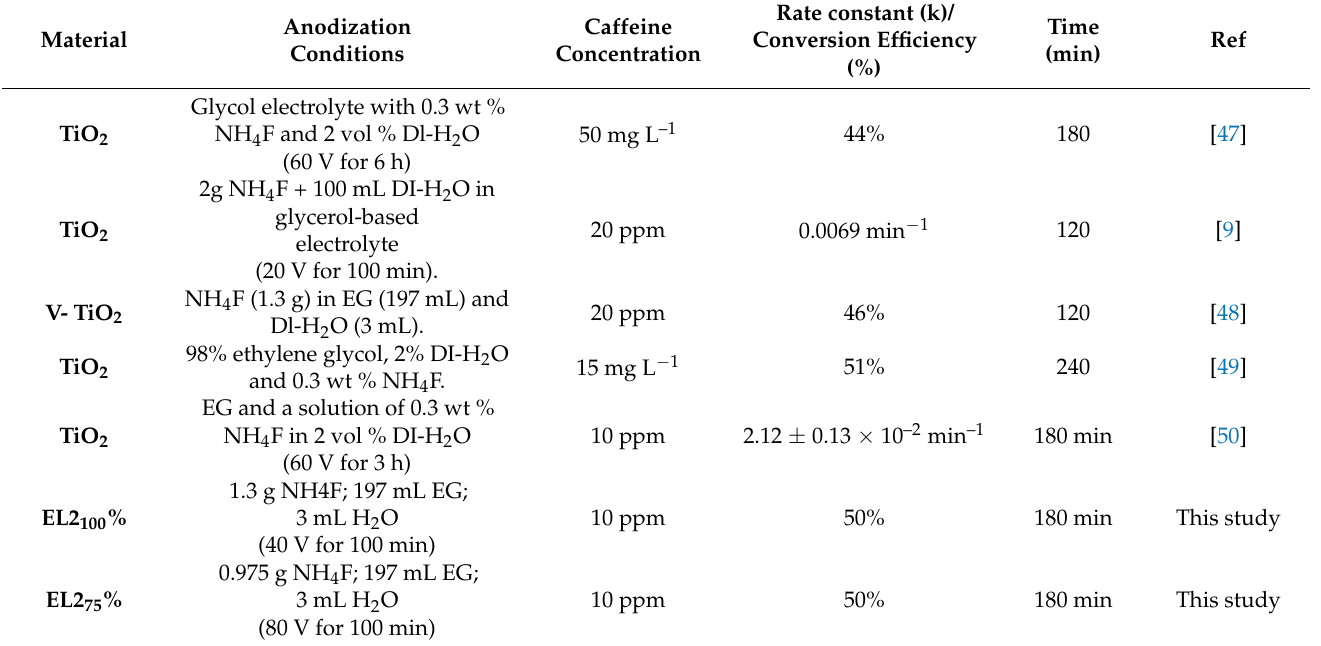
Table 3. The comparison of anodic TiO 2 based nanostructure for caffeine photocatalytic degradation. Anodization condition, target pollutant (and its concentration), rate constant, and time duration were taken from the